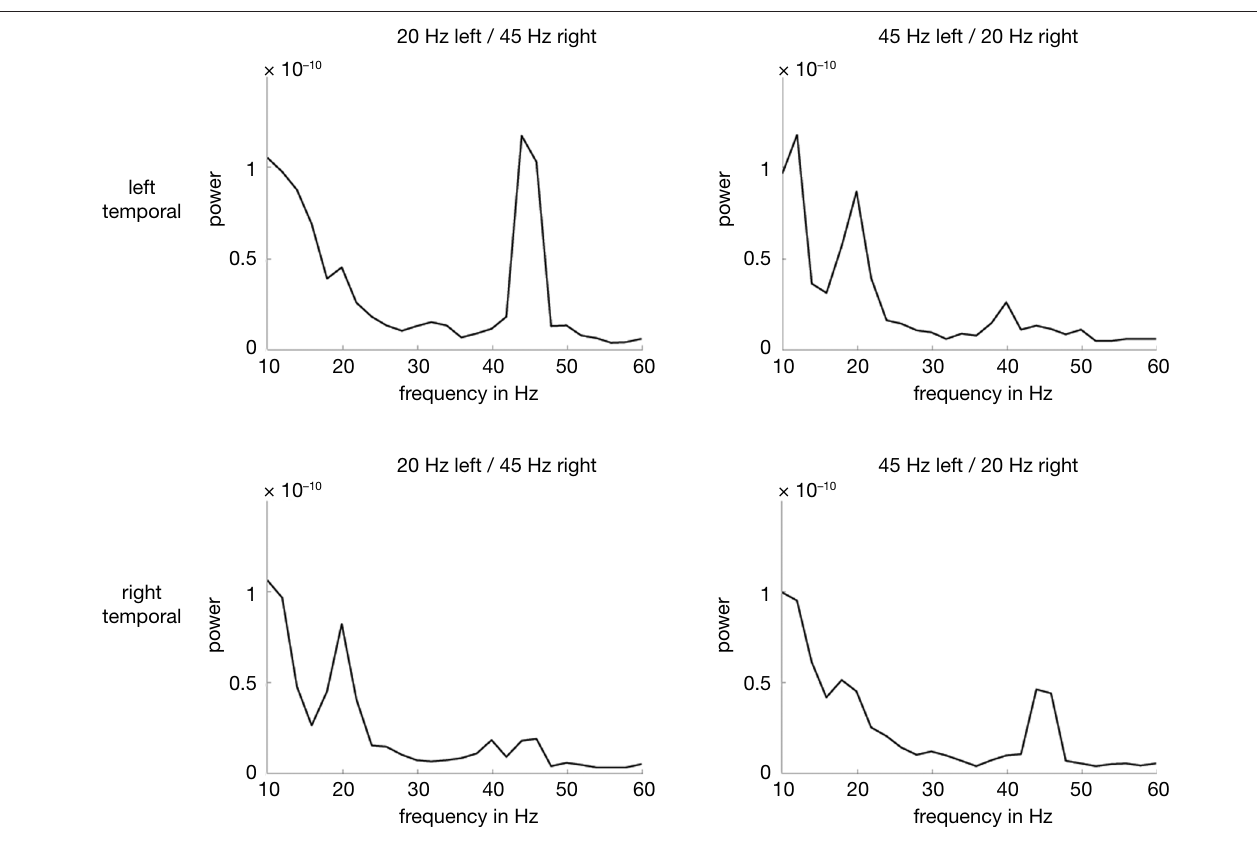
the 45 Hz modulated tone presented to the left ear and the 20 Hz modulated one to the right ear (45Hz/20Hz). The steady-state response prominently peaks in the hemisphere contralateral to the stimulation side. Moreover, concurrently with the 20 Hz response, the 40 Hz response is signifi cantly augmented.